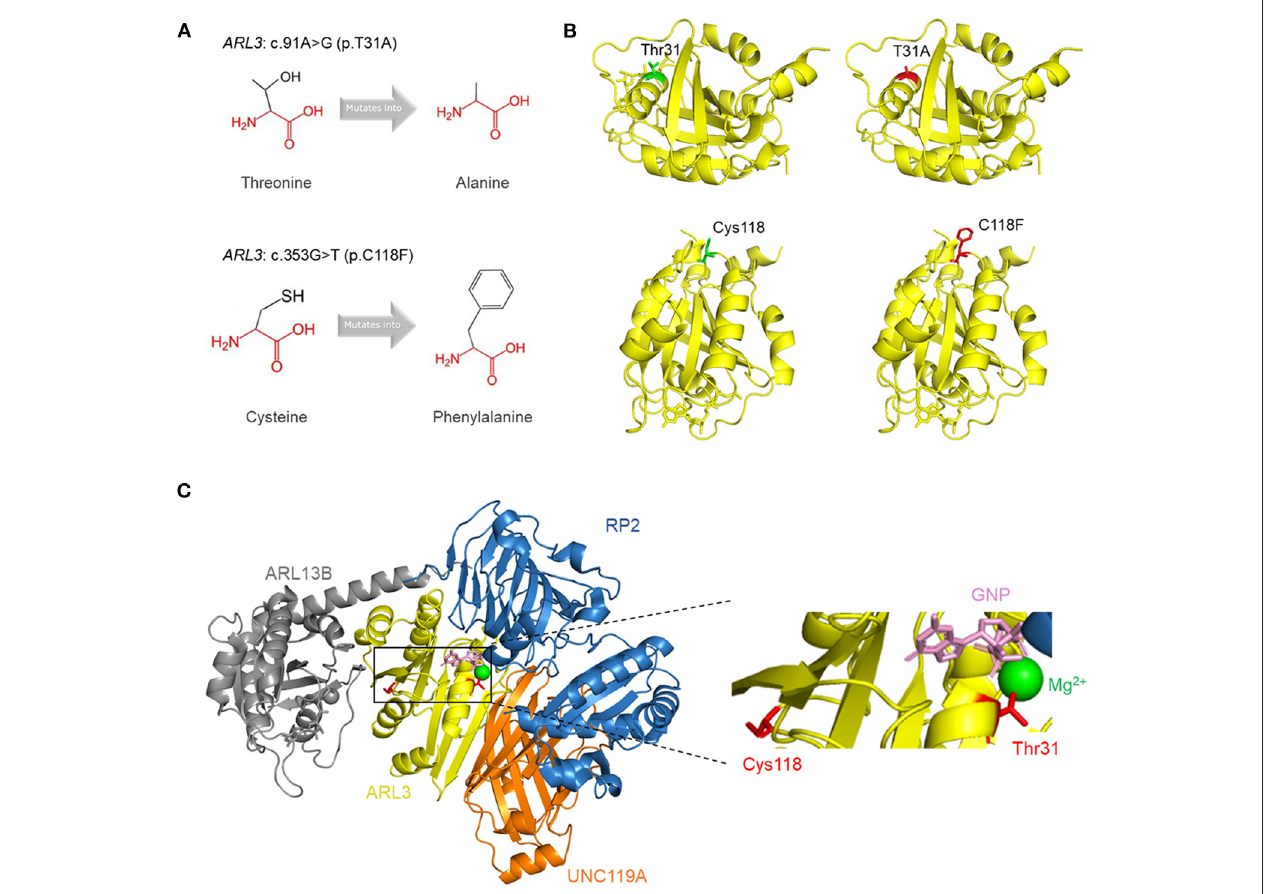
FIGURE 4 | Tertiary structure prediction of mutant proteins. (A) The schematic structures of the original and the mutant amino acids. The backbone was colored in red; the side chain was colored in black. (B) The 3D-structure of the wild-type and mutant proteins. The main structure of the ARL3 protein was colored in yellow. The side chains of the wild-type and the mutant residues were colored in green and red, respectively. (C) Superimposition of the structures of ARL3 (yellow) in complex with its interactors: RP2 (blue; PDB: 3BH6) (Veltel et al., 2008), ARL13B (gray; PDB: 5DI3) (Gotthardt et al., 2015), and UNC119A (orange; PDB: 4GOJ) (Ismail et al., 2012). On the right side is a zoomed-in view of some structures, including GNP (pink), Mg 2 + (green), and the side chains of Thr31 and Cys118 (red).